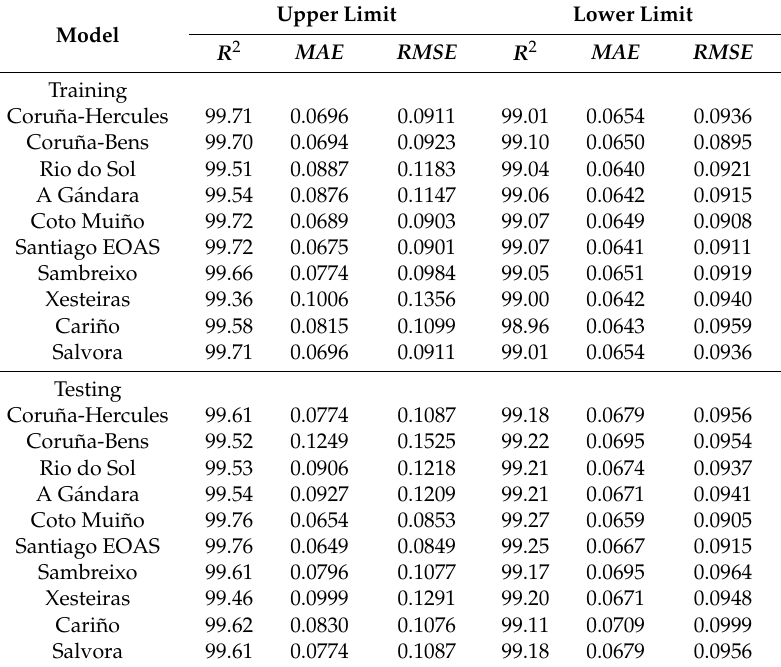
Table 7. Results of the training and testing of the MLR models of approach 1.